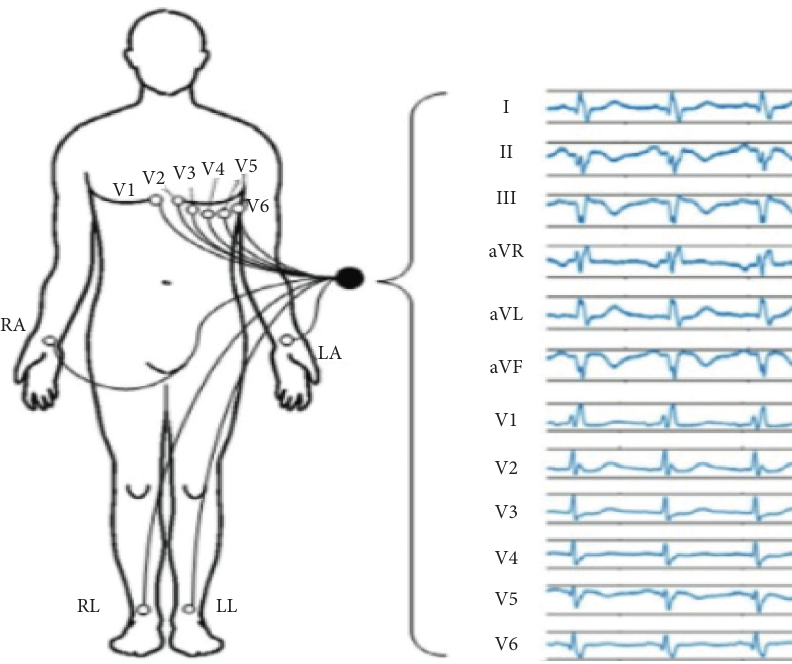
Figure 1: Heart electrical